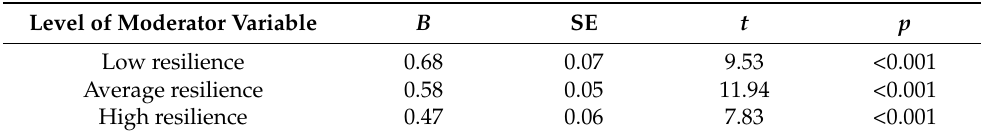
Table 4. Effects of subjective stress burden on symptoms of anxiety at low, average and high levels of resilience.